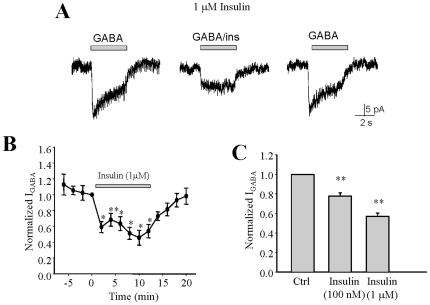
GABA-evoked currents (IGABA) is inhibited by insulin in INS-1 cells.GABA-evoked inward current was measured by means of a computer-controlled multi-barrelled perfusion system, in two-minute intervals, under voltage-clamp conditions. Representative traces of GABA-evoked currents in the absence and presence of insulin (100 nM, (A), 1 µM, (B)) in the same INS-1 cell. A' and B' represents the average of IGABA from separated experiments. (C) Normalized average IGABA during the course of experiment (control = average of first 4 IGABA, insulin = average of IGABA in the presence insulin at indicated concentrations). Data were mean ± SE. *p<0.05 ** p<0.01, n = 6.